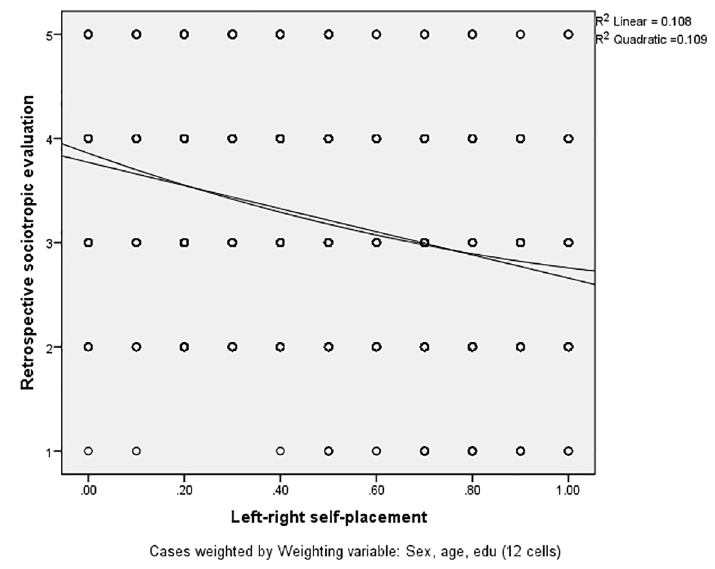
Figure 10. Linear and quadratic relationship between political ideology and negative retrospective sociotropic economic evaluation.